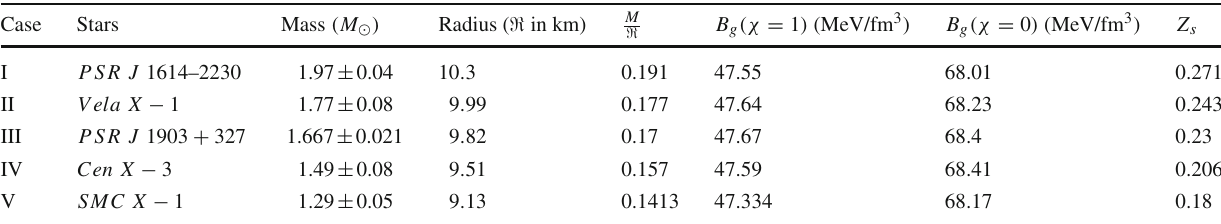
Table 1 Mass and radius of different strange star candidates [158]